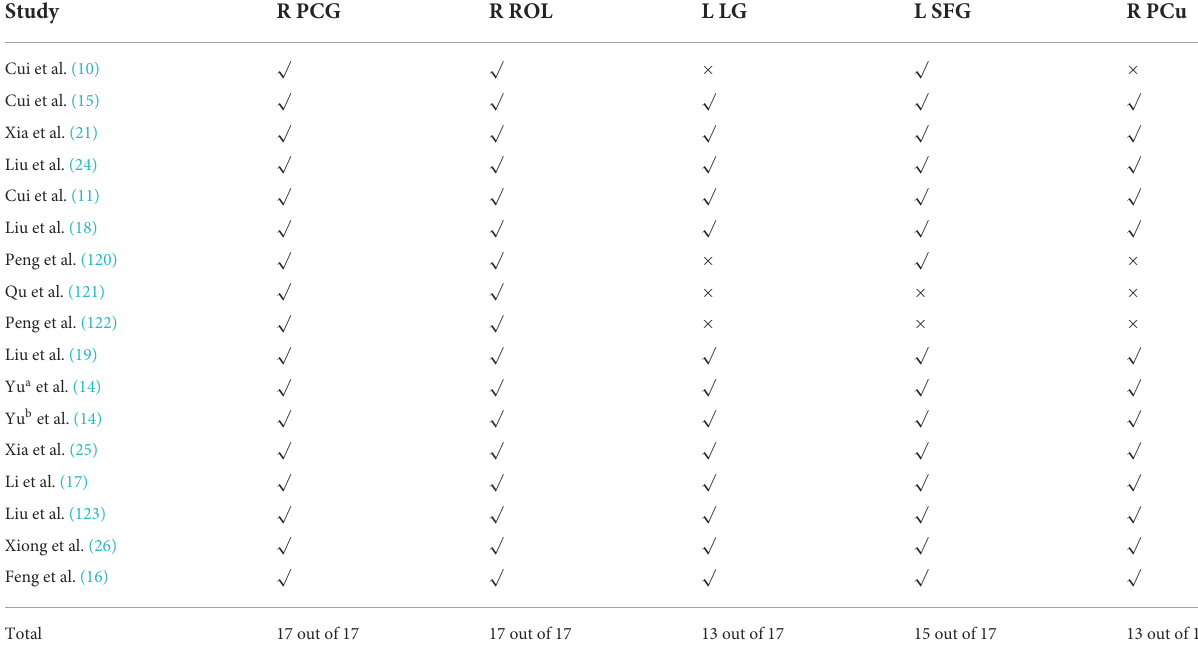
TABLE 6 Sensitivity analysis of the group 1.